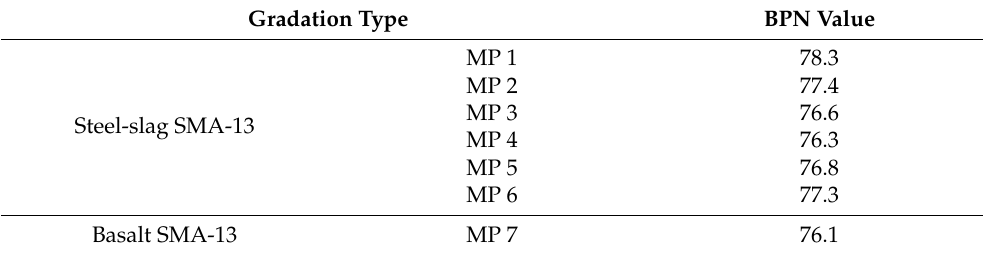
Table 10. British pendulum values for the road surface.